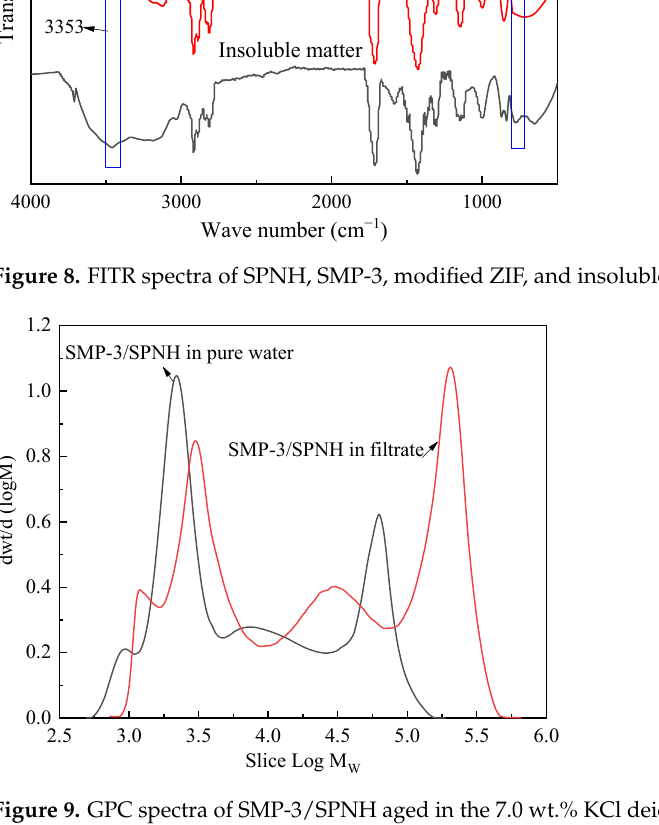
Figure 9. GPC spectra of SMP-3/SPNH aged in the 7.0 wt.% KCl deionized aqueous solution and the filtrate. Table 1. Molecular weights of SMP-3/SPNH aged in the 7.0 wt.% KCl deionized aqueous solution and the